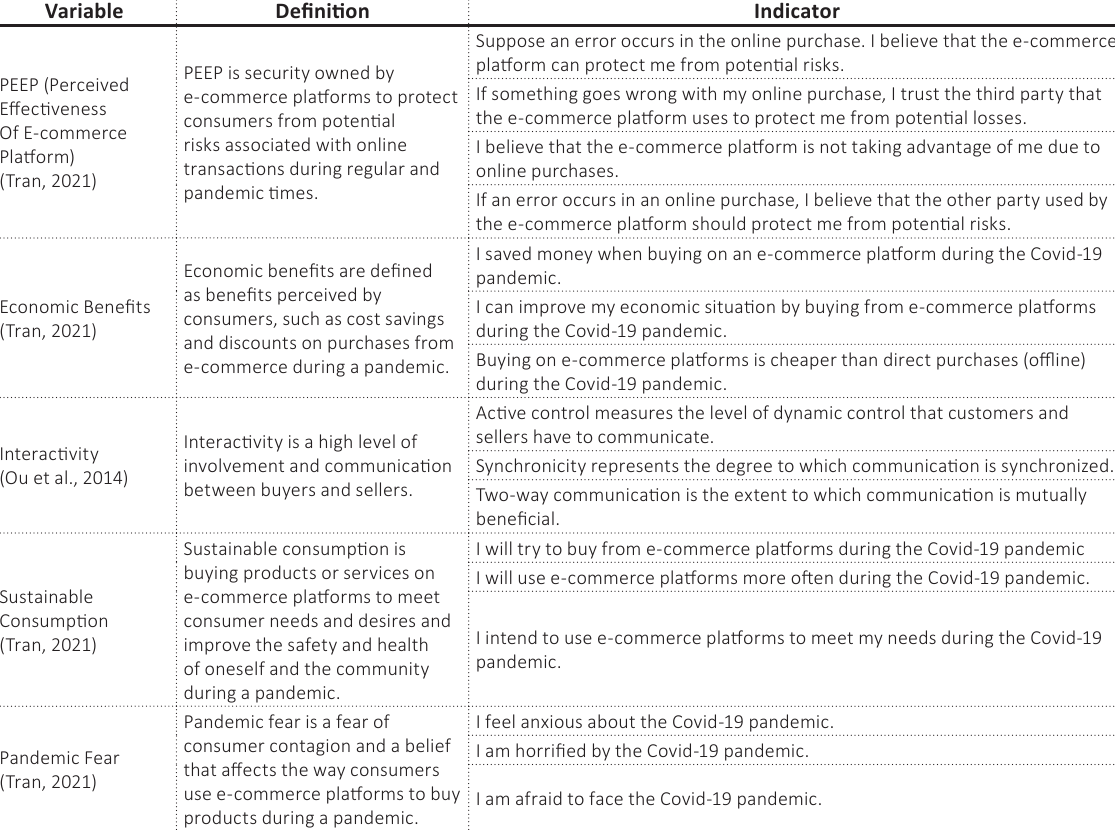
Table 1. Operational